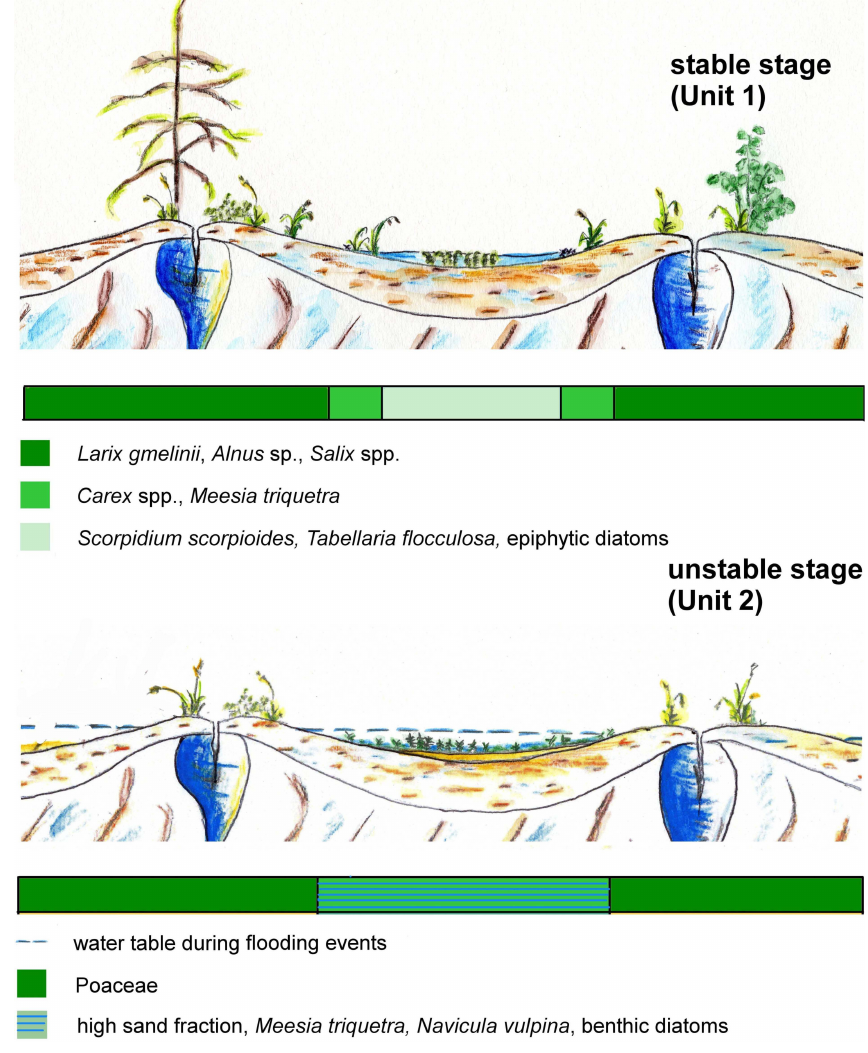
Fig. 10. Presentation showing vegetation cover during stable (Unit 1) and unstable (Unit 2) stages. For Unit 1 we detected a shrub–tussock tundra with scattered occurrences of Larix , while Unit 2 had a high proportion of sand, which affected plant communities on the rim and in the water-saturated depression (with Meesia triquetra